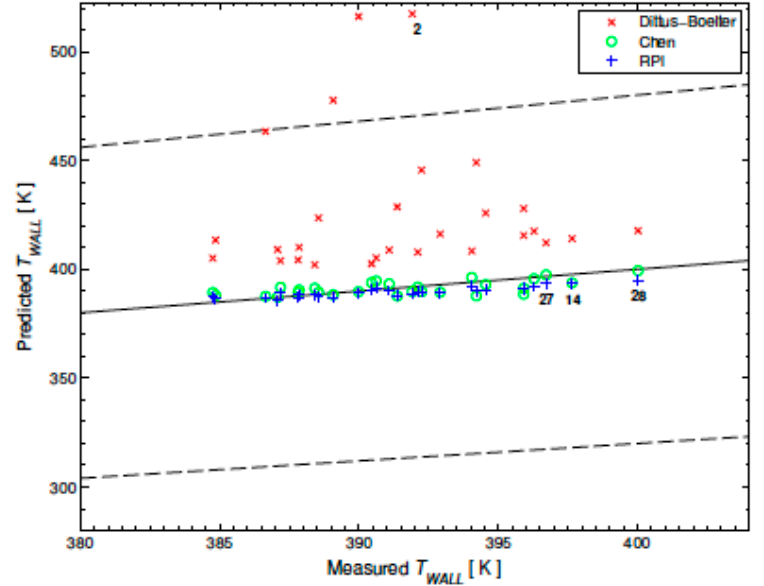
Figure 4. Comparison between measured wall temperatures, their values predicted using manual evaluation of the RPI model and boiling heat transfer correlations, for a typical boiling validation case. From [15].